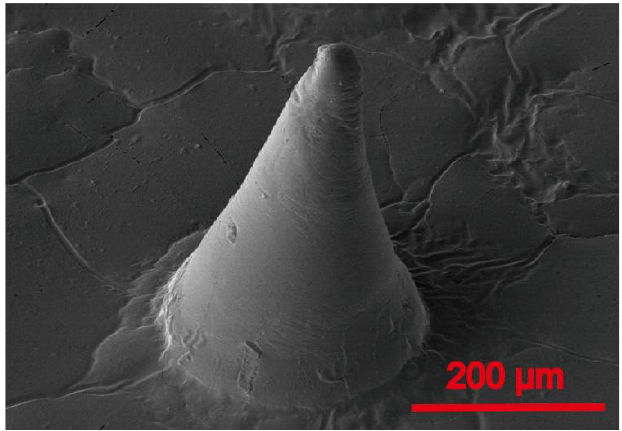
Figure A1. SEM picture of a microneedle.